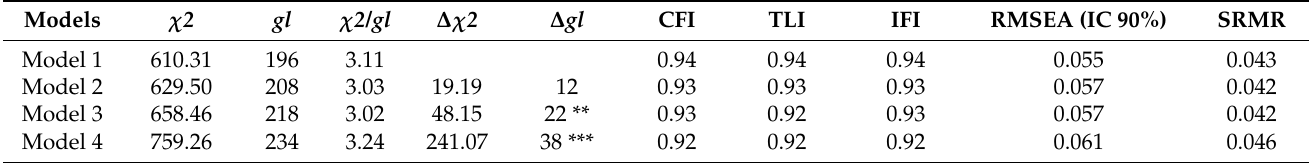
Table 1. Multigroup analysis of invariance with respect to gender.